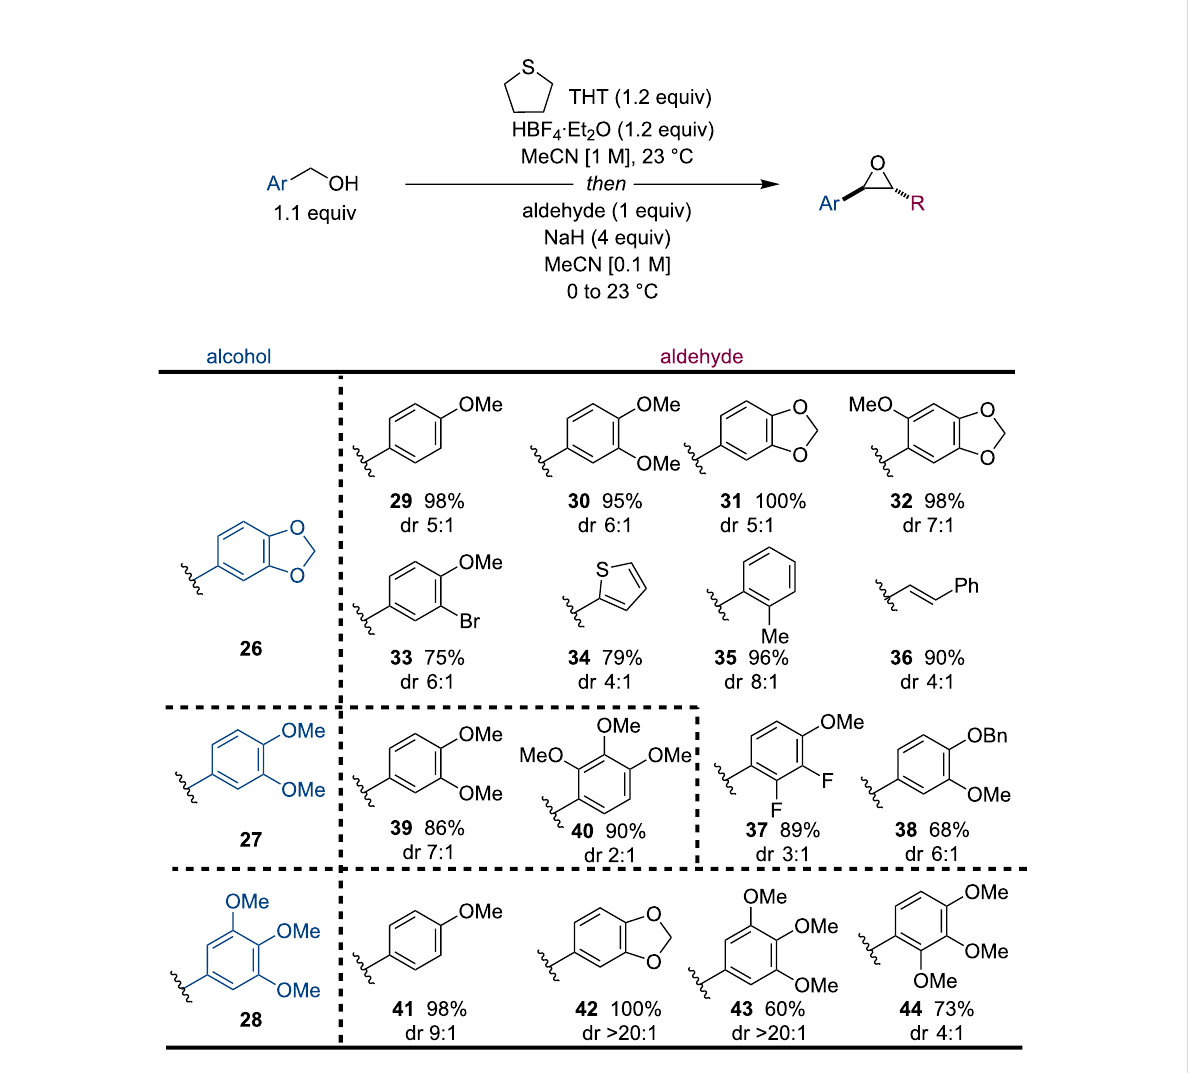
Figure 2: Scope of the reaction with electron-rich alcohols and